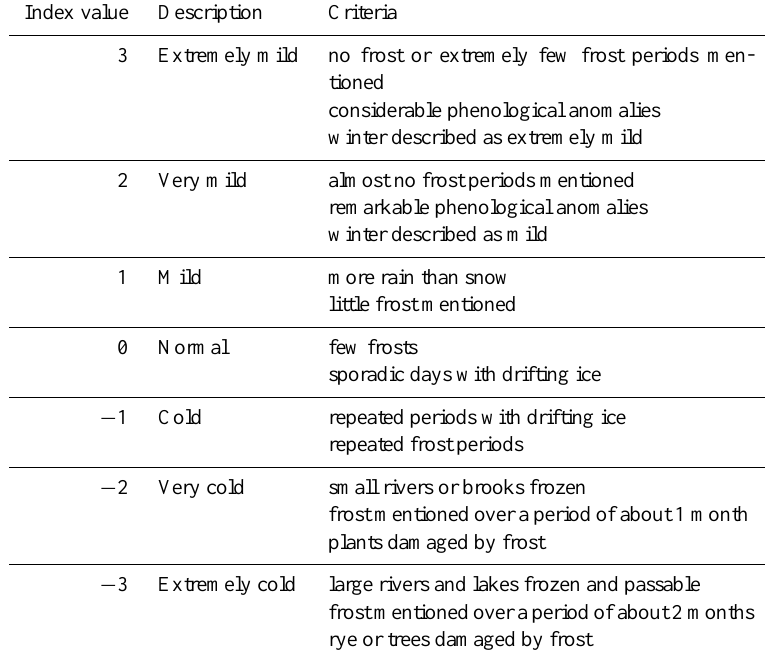
Table 3. Refined scale of the winter temperature index (Camenisch,